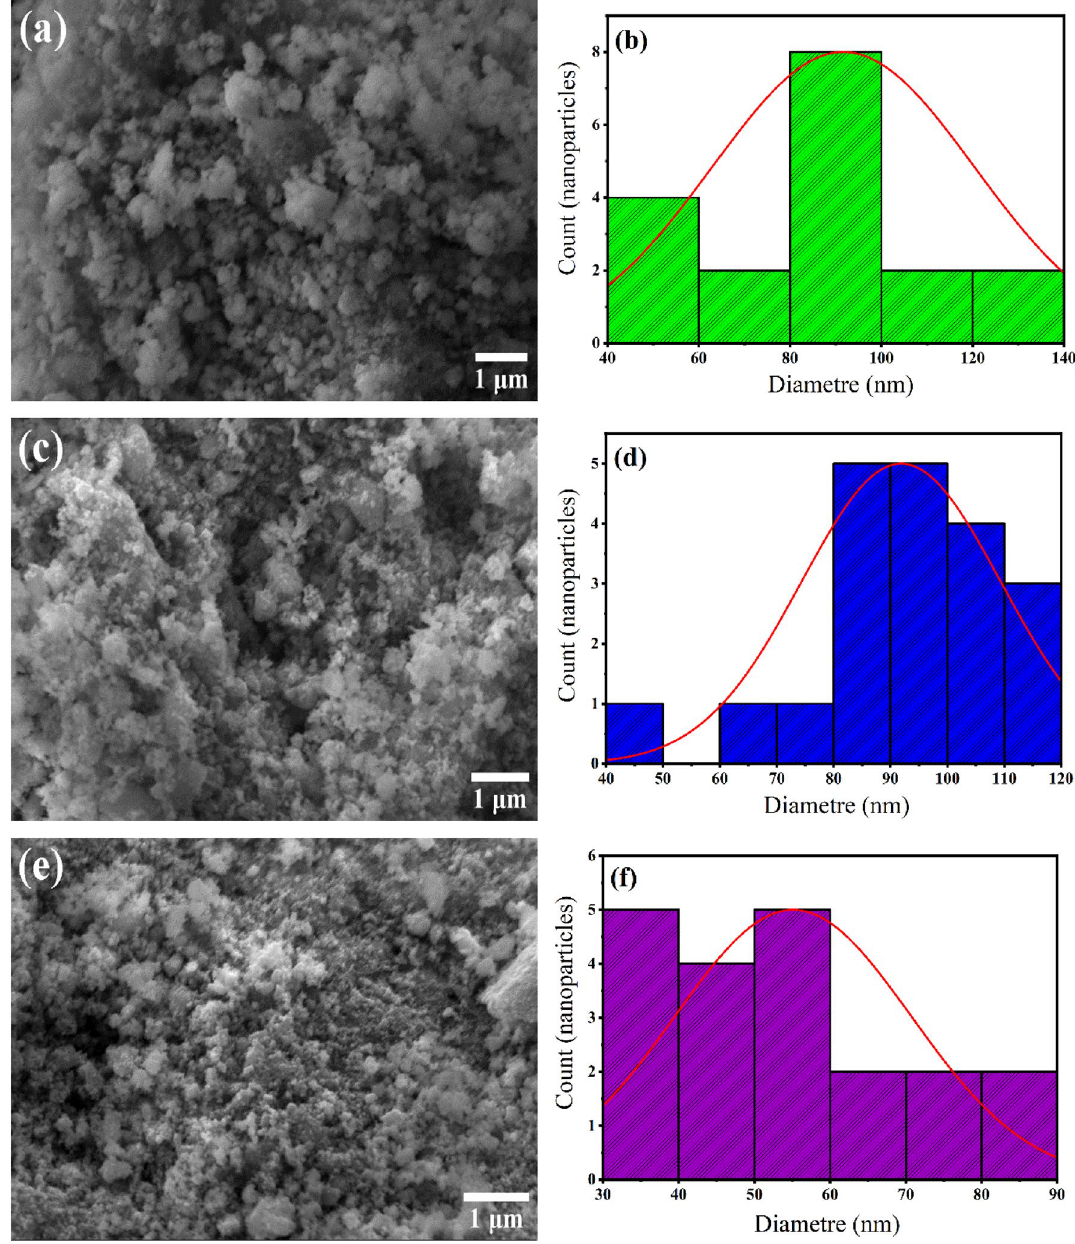
Figure 3. SEM images and particle size distributions of green synthesized α-Fe 2 O 3 , CuO, and ZnO NPs: ( a , b )